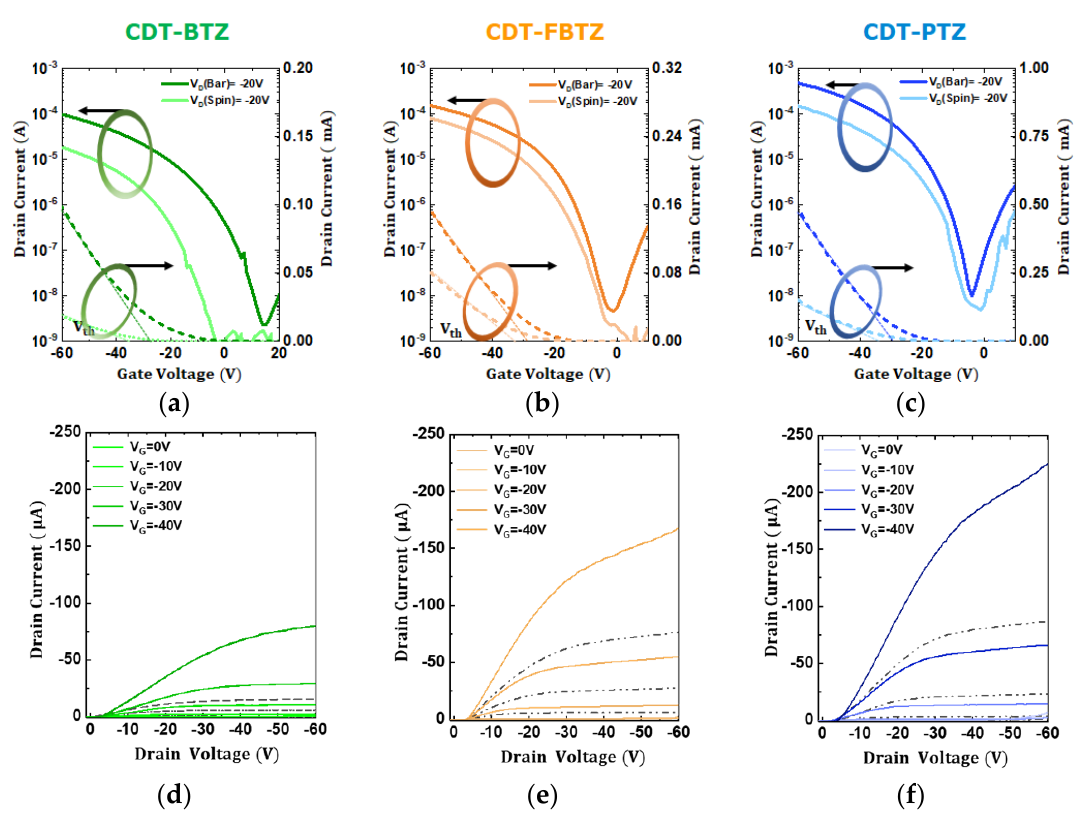
Figure 5. Linear regime transfer characteristics of the bar-coated and spin-coated ( a ) CDT-BTZ-, ( b ) CDT-FBTZ-, and ( c ) CDT-PTZ-based PFETs in the linear regime ( V DS = − 20 V). The output curves of the ( d ) CDT-BTZ-, ( e ) CDT-FBTZ-, and ( f ) CDT-PTZ-based PFETs with the bar-coating and spin-coating. Table 1. Summary of device parameters and Gaussian DOS parameters for bar-coated and spin-coated CDT series-based PFETs.